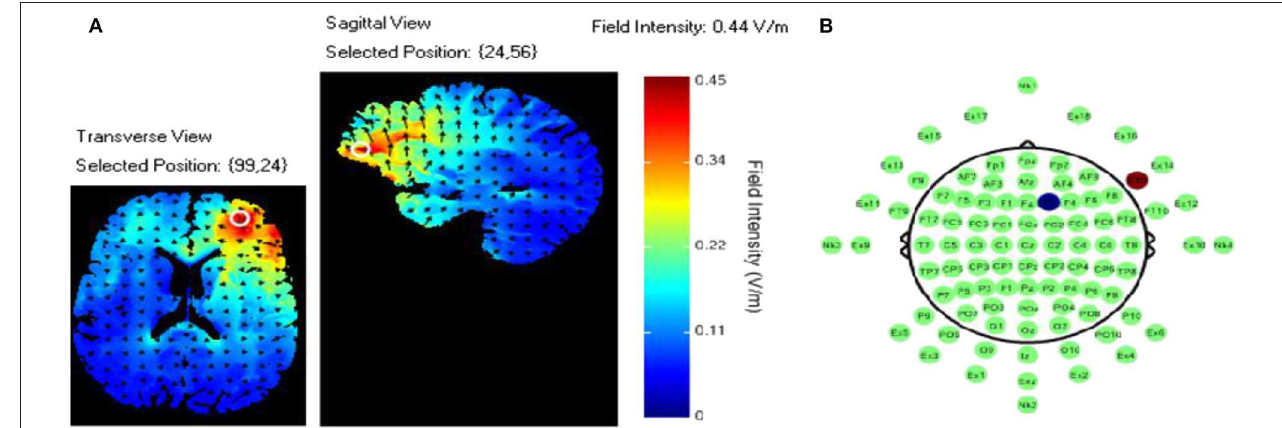
FIGURE 3 | (A) Current flow model. (B) TDCS montage: the red dot represents the anodal electrode over the F10 and the blue dot represents the cathodal electrode over the F2.